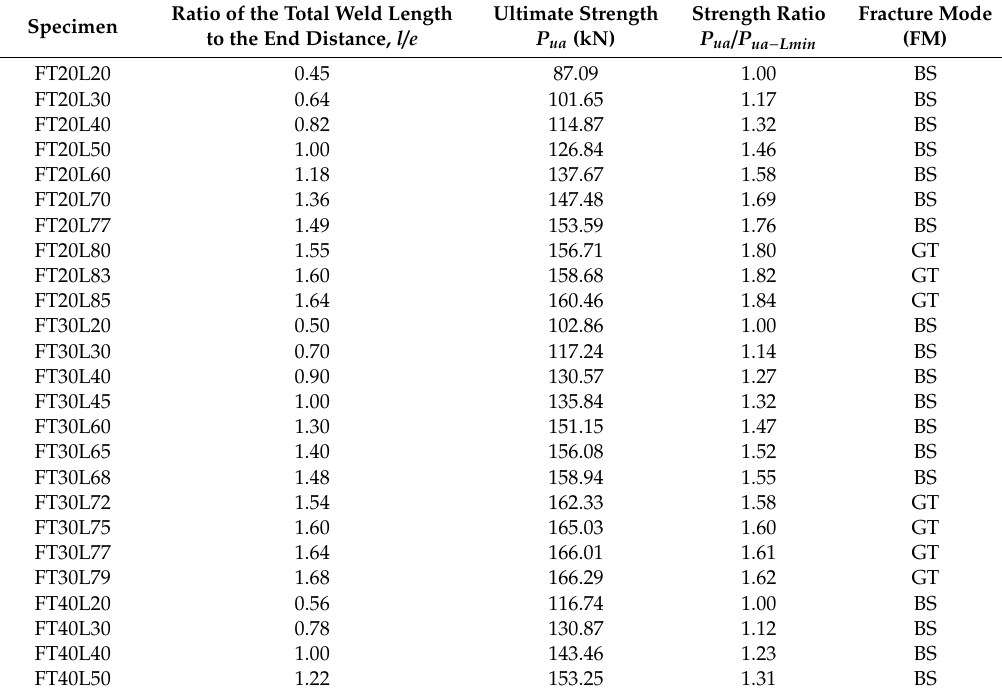
Figure 7. Stress and strain distribution along Paths 1 and 2 for FT20L20: ( a ) Definition and symbol of Paths 1 and 2 for FT20L20, ( b ) direct stress (S22, σ 22 ) and shear stress (S12, σ 12 ) in Path 1 and Path 2, ( c ) plastic direct strain (PE22) and plastic shear strain (PE12) in Path 1 and Path 2. Table 3. Parametric analysis